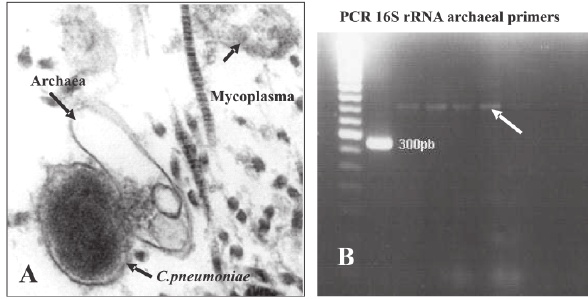
Figure 2 - A ) Electron micrograph of a vulnerable plaque exhibiting a Chlamydophila pneumoniae elementary body in close contact with an archaeal-suggestive element, which contains intracytoplasmic vacuoles. A mycoplasmal element is also present. 2B ) PCR test for archaeal DNA was positive in 4 of the 6 cases (arrow points to the 400 bp product; left channel is the positive